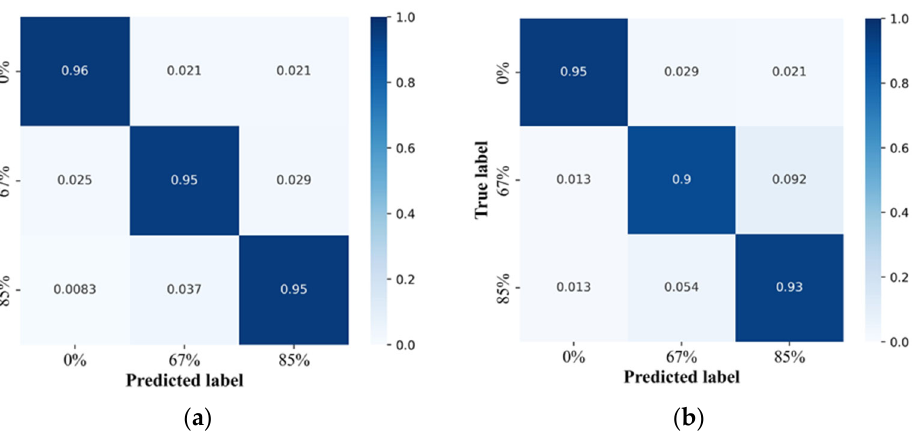
Figure 8. 1RM Recognition Performance ( a ) with attentional focus and ( b ) without attentional focus.